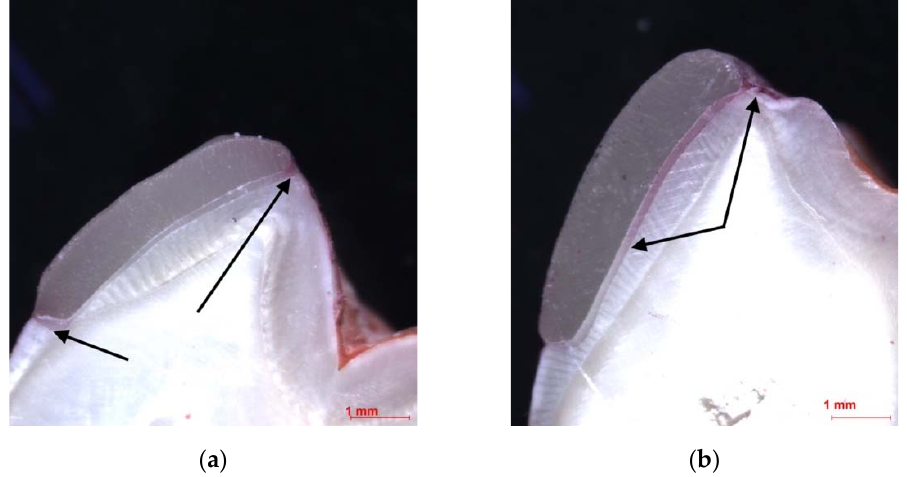
Figure 7. Stereo microphotography showing different discoloration intensities: ( a ) slight cement layer discoloration, 20× magnification; ( b ) extensive cement layer discoloration, 20× magnification.